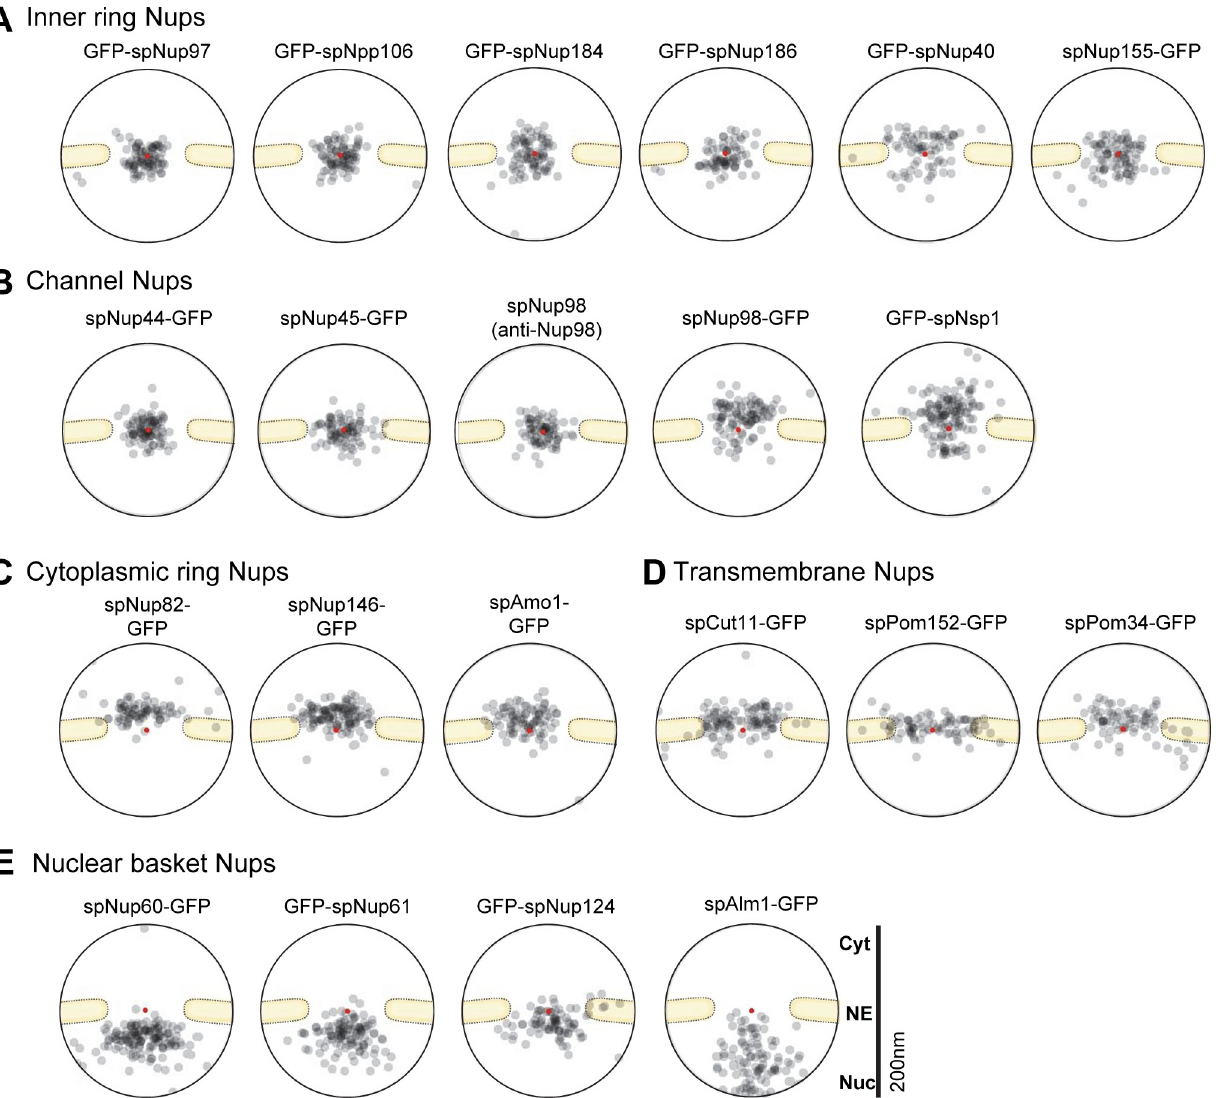
Fig 7. IEM of S . pombe nucleoporins. (A) Inner ring Nups. (B) Channel Nups. IEM for spNup98 was performed using an anti-Nup98 antibody (13C2) for the wild type strain and an anti-GFP antibody for the spNup98-GFP strain. (C) Cytoplasmic ring Nups. (D) Transmembrane Nups. (E) Nuclear basket Nups. The localization of the other nuclear basket Nup, spNup211, is shown in Fig 3A. Immunogold distributions are shown based on the projected immunoelectron micrographs for quantitative representation. The red points indicate the pore centers. Projections of raw IEM images are shown in S5C– S5G Fig. Individual IEM micrographs of 20 NPCs are available in S11